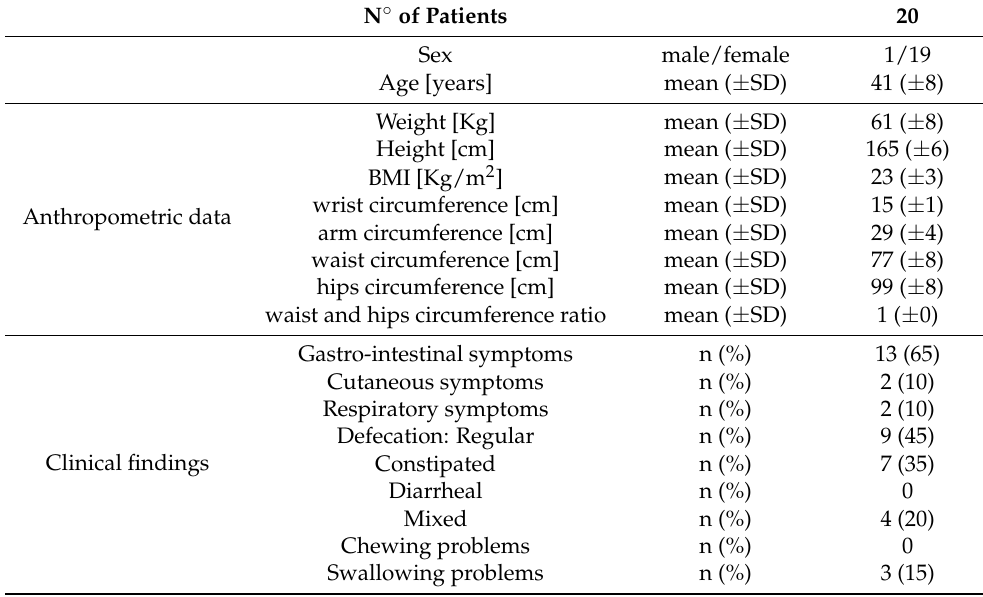
Table 2. Baseline characteristics of patients suffering from SNAS during COVID-19